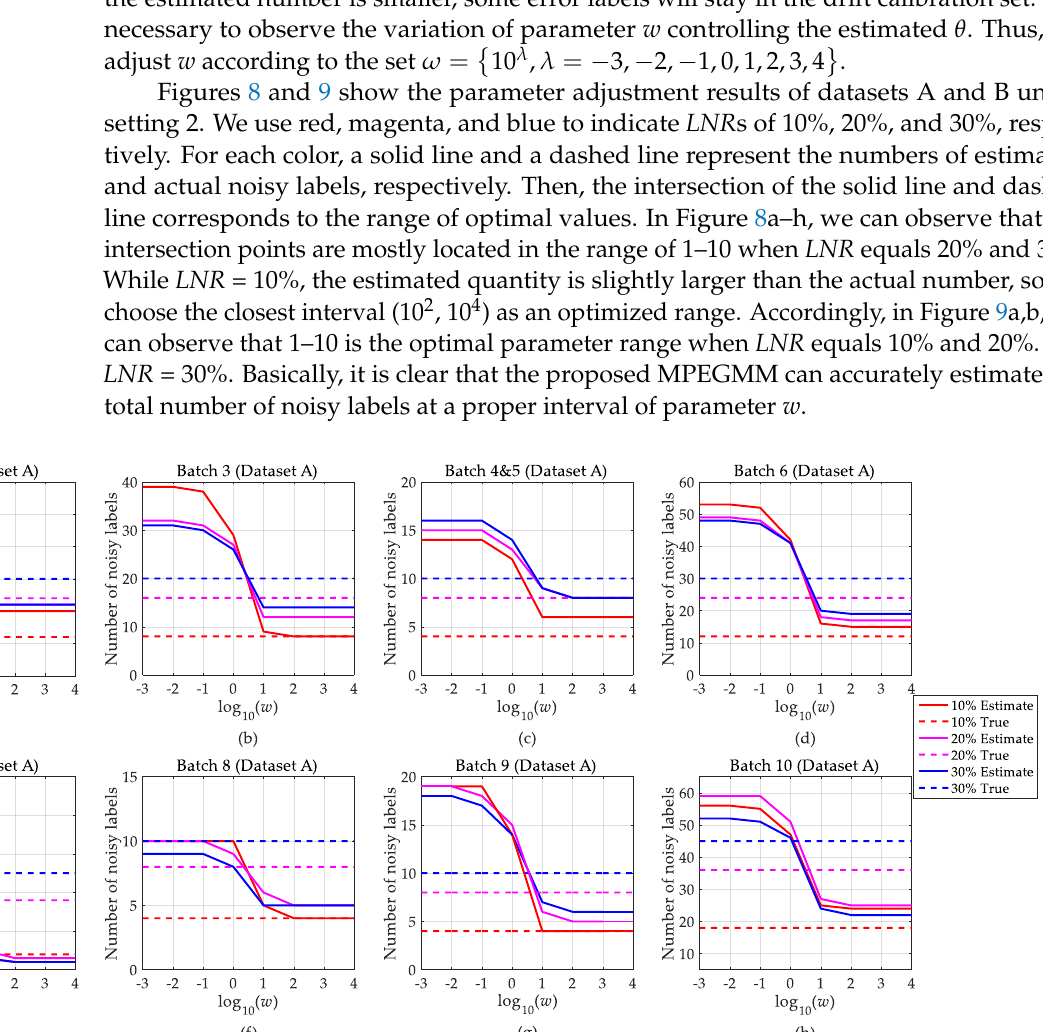
Figure 9. Estimated number of noisy labels with w (dataset B). ( a ) Noisy number of batch 2; ( b )